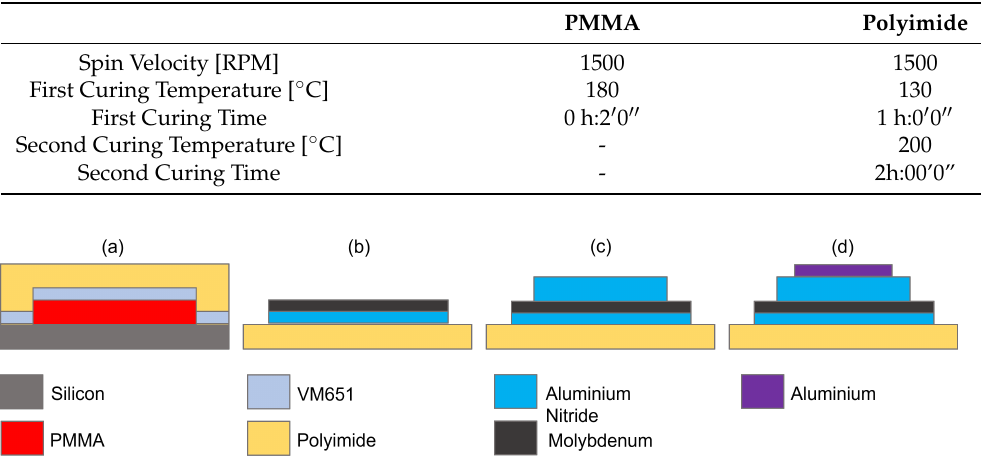
Figure 2. Fabrication steps for the resonator: ( a ) substrate preparation, ( b ) bottom electrode pattern- ing, ( c ) piezoelectric deposition, ( d ) top electrode